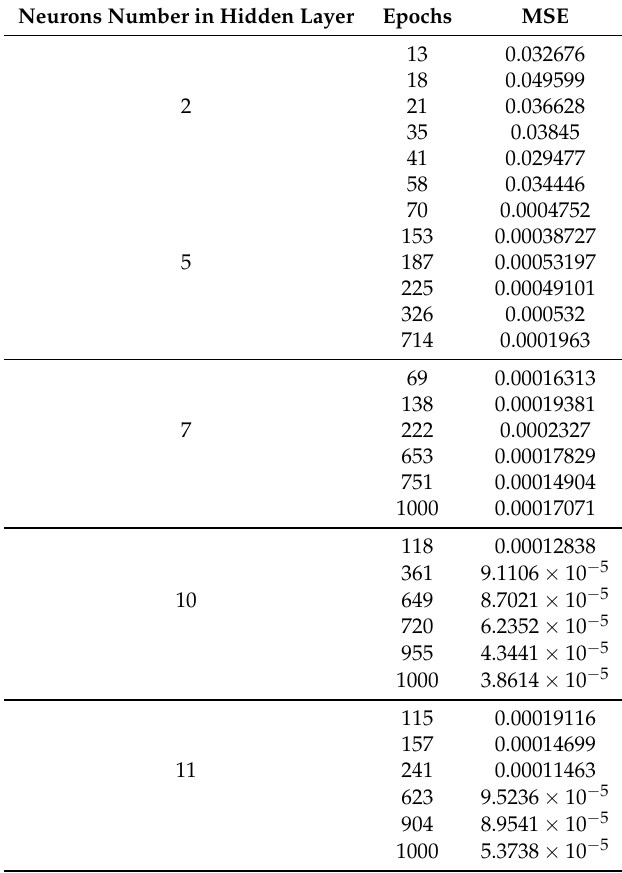
Table A1. Levenberg–Marquardt training